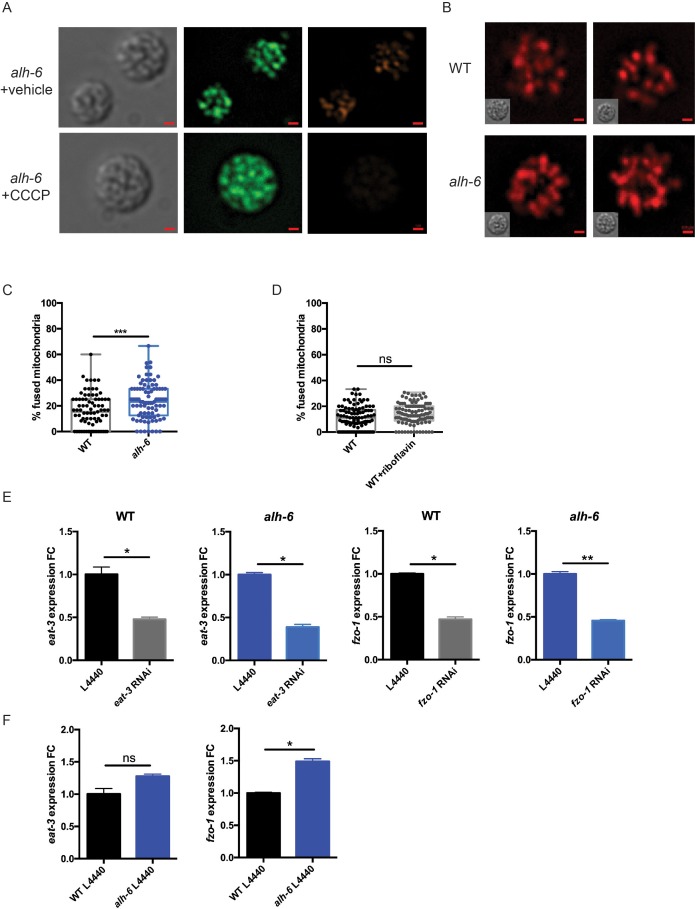
fzo-1 is involved in mitochondrial dynamics aberration in alh-6 spermatids.(A) JC-1 stained alh-6 spermatid mitochondria show sensitivity to mitochondrial uncoupler CCCP treatment. Intensity of red mitochondria species (J-aggregates) are dissipated while that of green mitochondria species (monomers) are intensified, indicating membrane depolarization (Note that CCCP treatment is known to cause cellular swelling). Scale bar = 1 uM. (B) alh-6 spermatid mitochondria stained with MitoTracker Red CMXRos show increased fusion compared to WT male spermatids. Scale bar = 0.5 uM. (C) Spermatids of alh-6 males fed HT115 diet still display increased mitochondrial fusion compared to spermatids of age-matched WT males. (D) Riboflavin supplementation did not alter mitochondria fusion in spermatids of WT males. (E) eat-3 and fzo-1 RNAi knockdown in WT and alh-6 mutants are verified using RT-PCR. (F) fzo-1 expression is increased in alh-6 mutants, while eat-3 expression is not significantly increased. Statistical comparisons done by unpaired t-test. *, p<0.05; **, p<0.01; ***, p<0.001; ****, p<0.0001. All studies performed in biological triplicate; refer to Supplementary file 1 for n for each comparison.